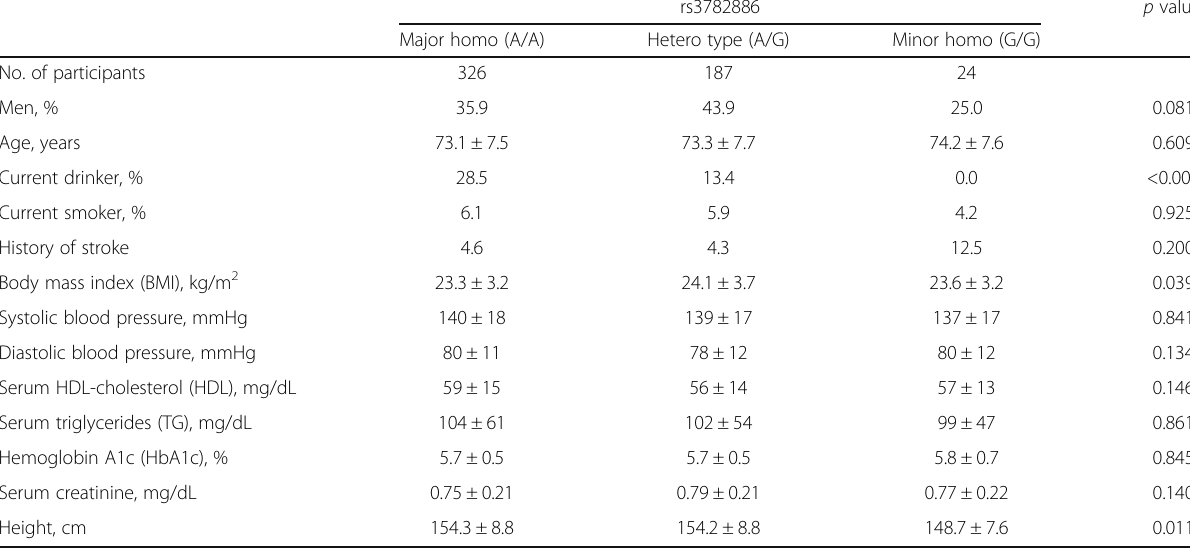
Table 1 Characteristics of the study population by rs3782886